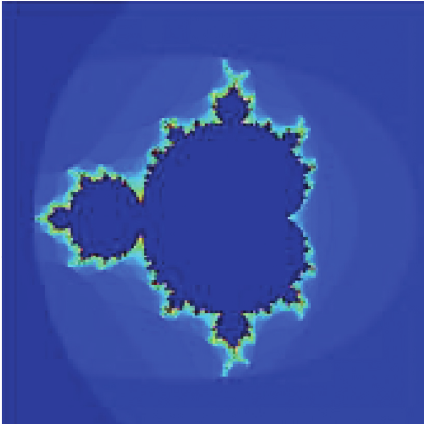
Figure 2: The general Mandelbrot set for the critical point ( z ) . (− 1/2 , 0 ) of P 2